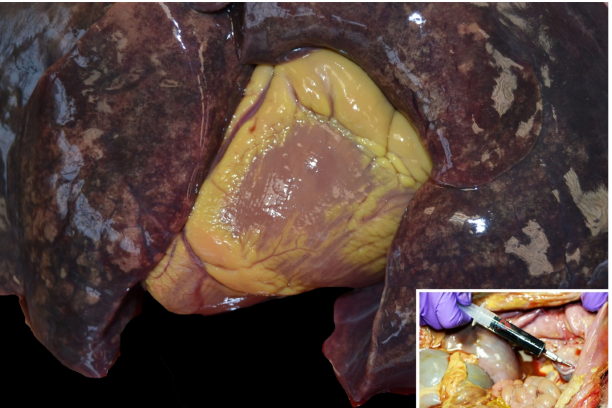
Figure 3. Marked yellow discoloration of the epicardial fat of a lamb with icterus. Inset: Dark red urine in a lamb with hemoglobinuria. Note diffuse icterus in abdominal and pelvic cavity tissues.